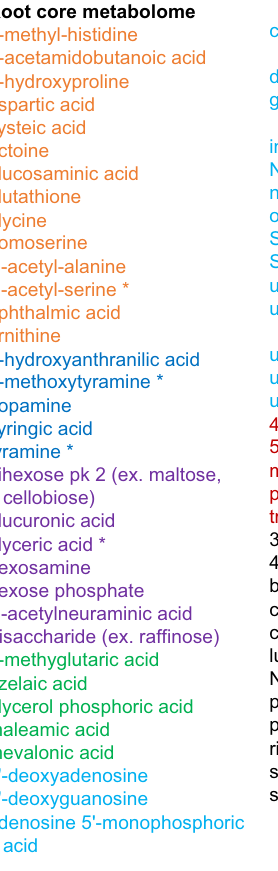
nucleosides, nucleotides and derivatives, red: organic acids, black: other. *: and/or isomers. # changing signi fi cantly diurnally in exudates of at least one species (Anova/Tukey test, p <0.05, p -values are given in Supplementary Data 1). Speci fi c metabolites of this dataset are presented in Fig.